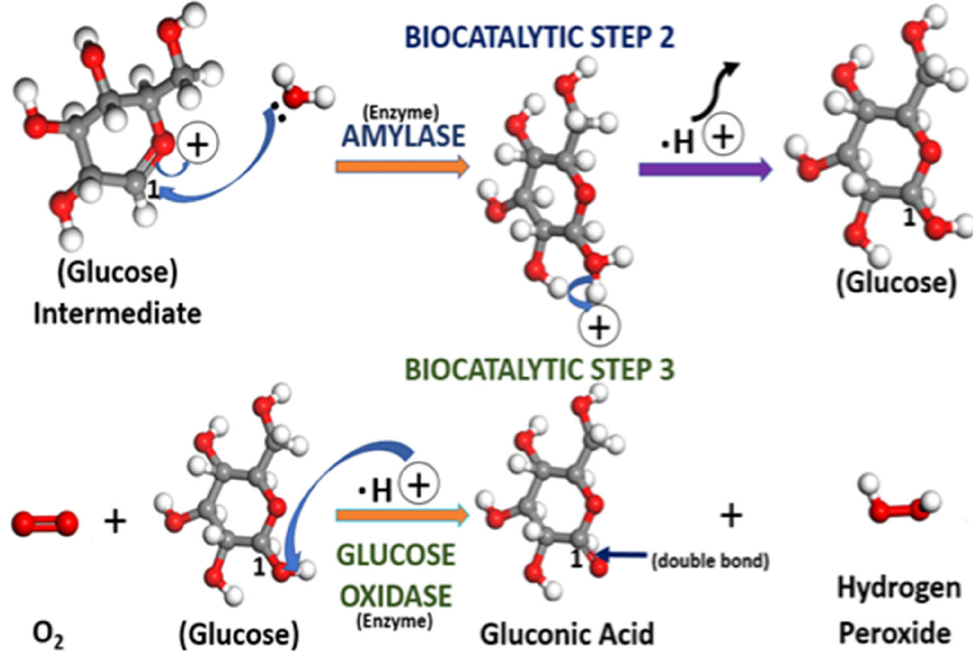
Figure 10. The step 2 and step 3 mechanisms for glucose intermediate decomposition to glucose and the oxidation of glucose (C 6 H 12 O 6 ) to gluconic acid (C 6 H 11 O 6 ) and hydrogen peroxide. Step 2 uses the enzyme amylase, whereas step 3 has the enzyme glucose oxidase as the promotor of the reaction. The index “1” is used to indicate the position of the C=O double bond throughout the mechanism. The gray, red, and white spheres represent carbon, oxygen, and hydrogen, respectively.